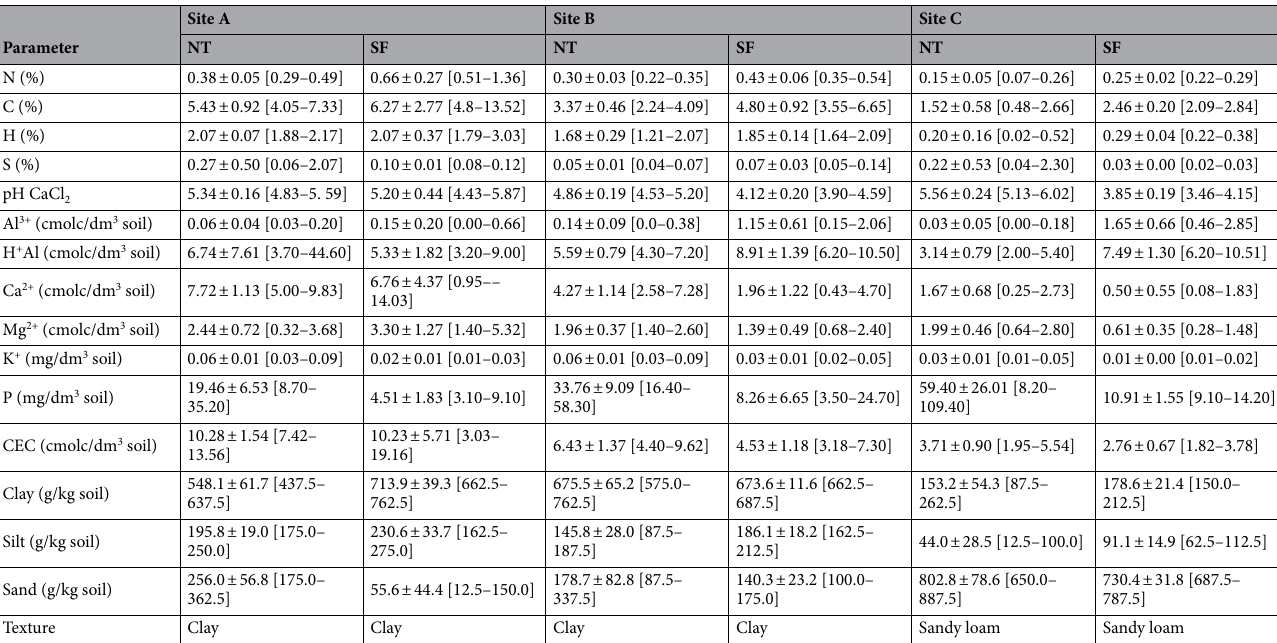
Table 1. Soil physical–chemical properties and soil types of the three sampling areas (A, B and C) of no-tillage farms (NT) and secondary forests (SF). Data presents average values ± standard deviation and [minimum– maximum] values.